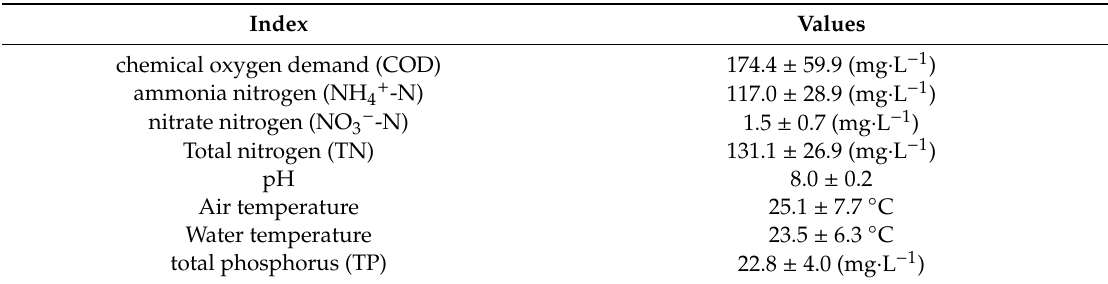
Table 1. Qualities of synthetic livestock wastewater in